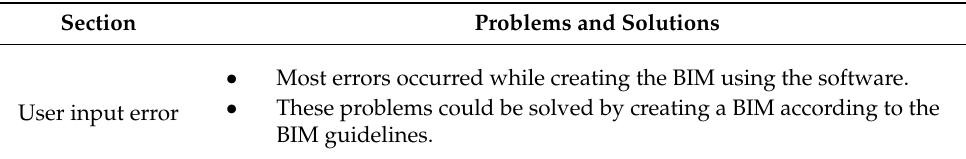
Table 14. The results of quality checks against construction check